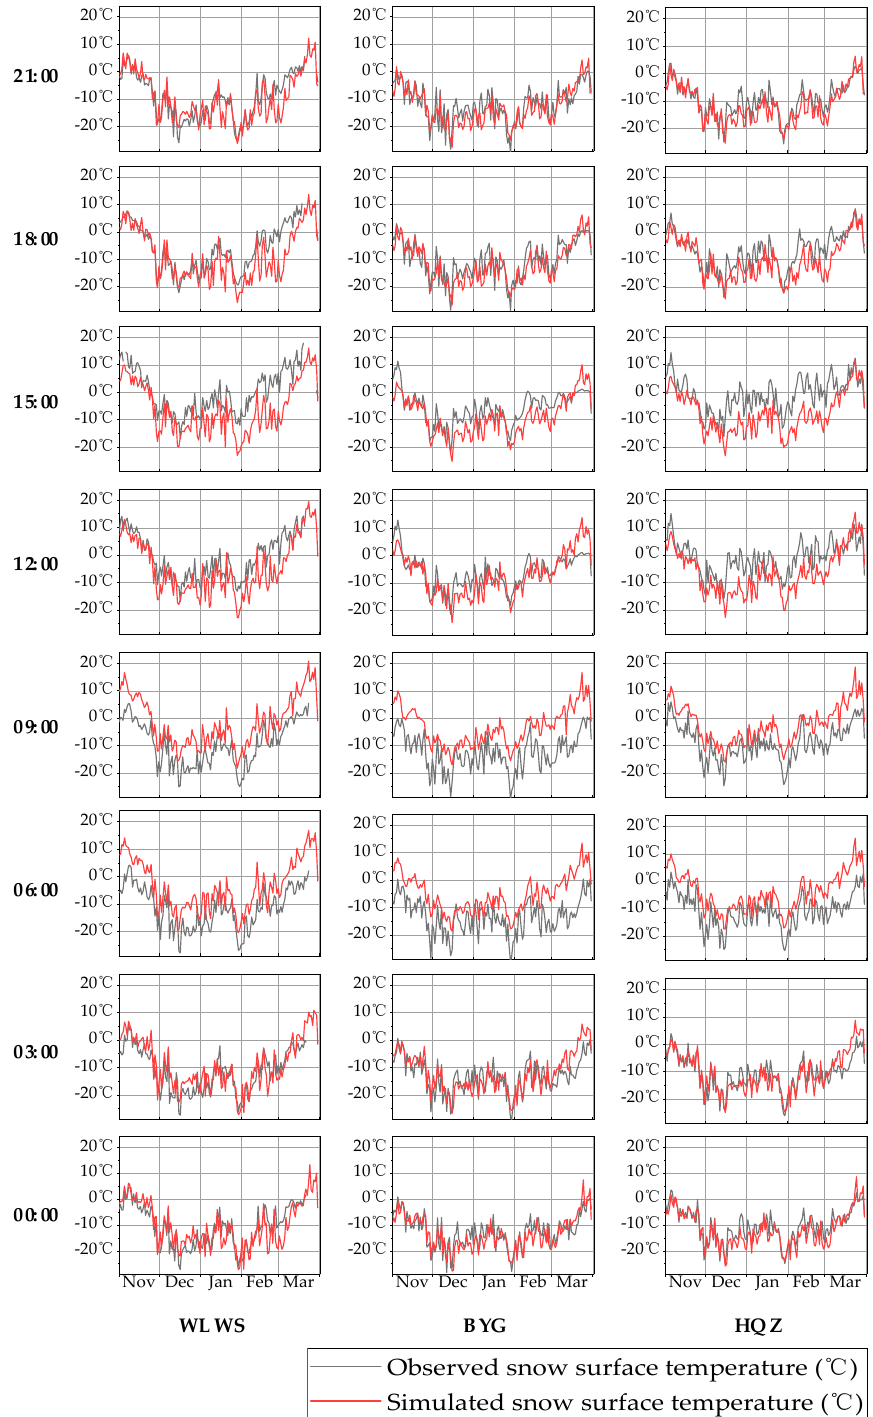
Figure 5. The time series data of the measured (three automatic snow variable measurement systems) and simulated 3-hour average snow surface temperatures between 0:00 on 1 November 2014 and 21:00 on 31 March 2015.